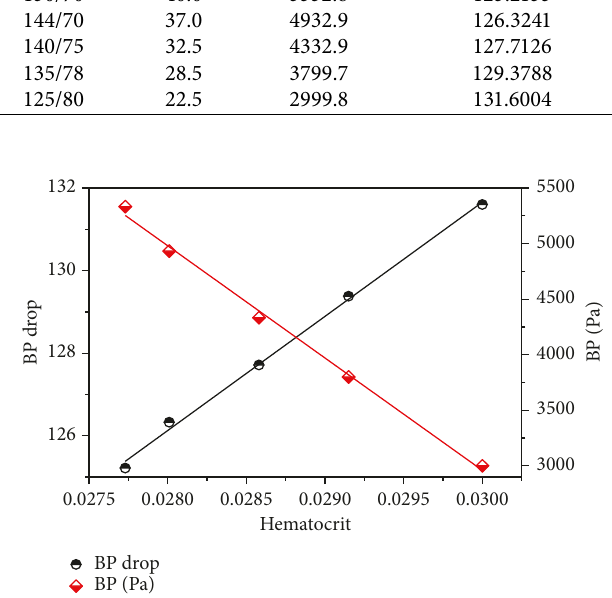
Figure 2: Mathematical data of BP drop (calculated using (66)) and BP (in Pa) as a function of hematocrit, by Table